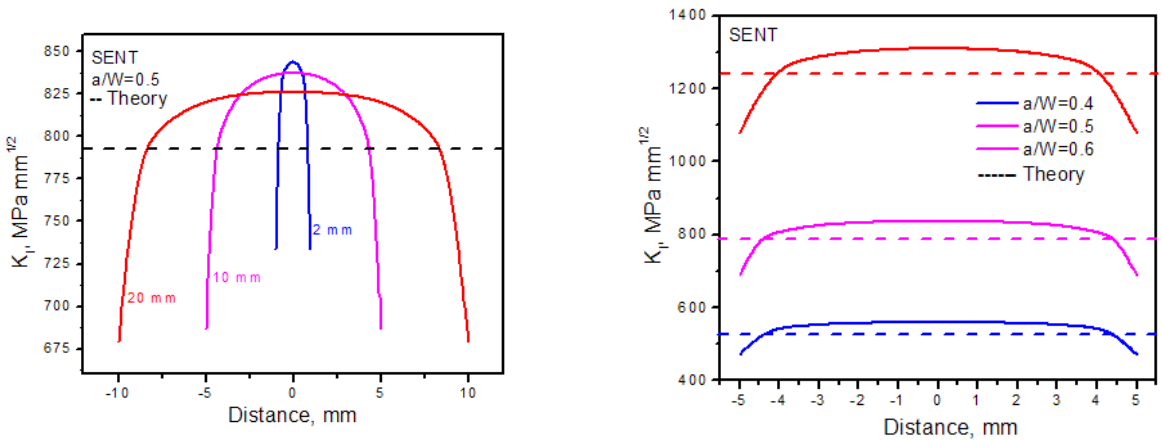
Figure 10: Variation of K I along the crack-front for various a/W ratio and specimen thickness 10